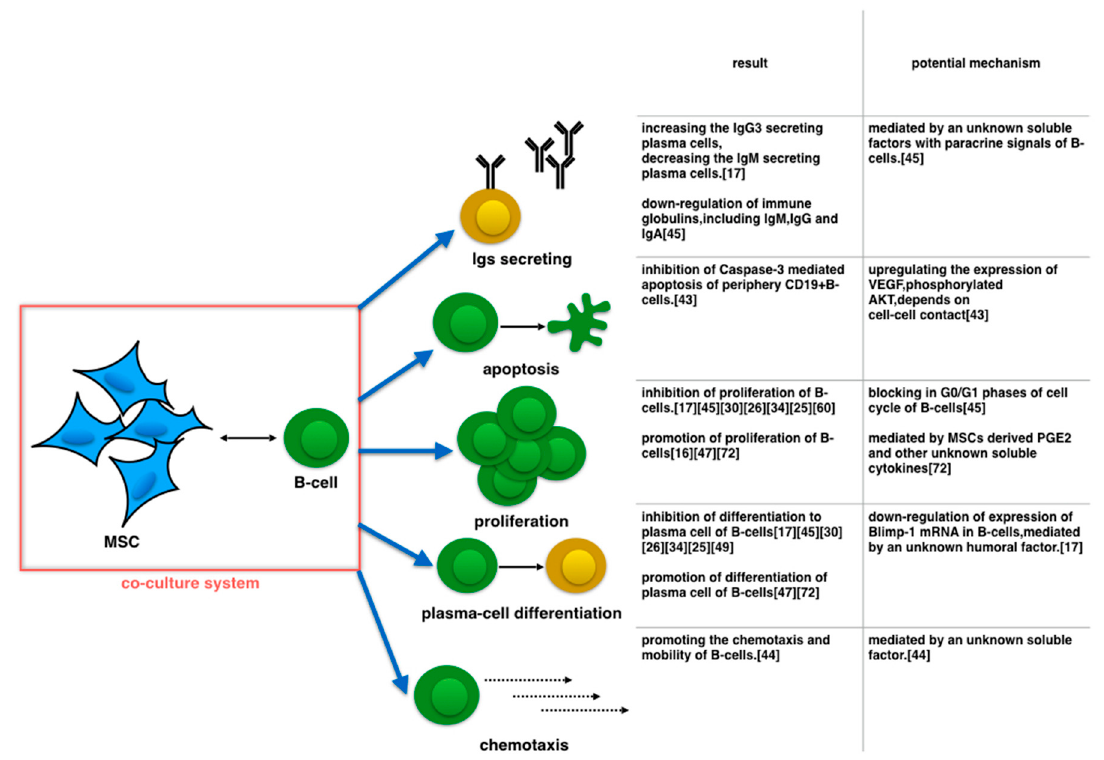
Figure 1. When MSCs are co-cultured with B-cells in basic condition, MSCs regulate Igs-secreting, apoptosis, proliferation, plasma-cell differentiation and chemotaxis of B-cells. For indefinite reasons, such as diverse stimulators of B-cells in culture medium, regulations of proliferation, plasma-cell differentiation and Igs secreting of B-cells are unable to reach agreement.